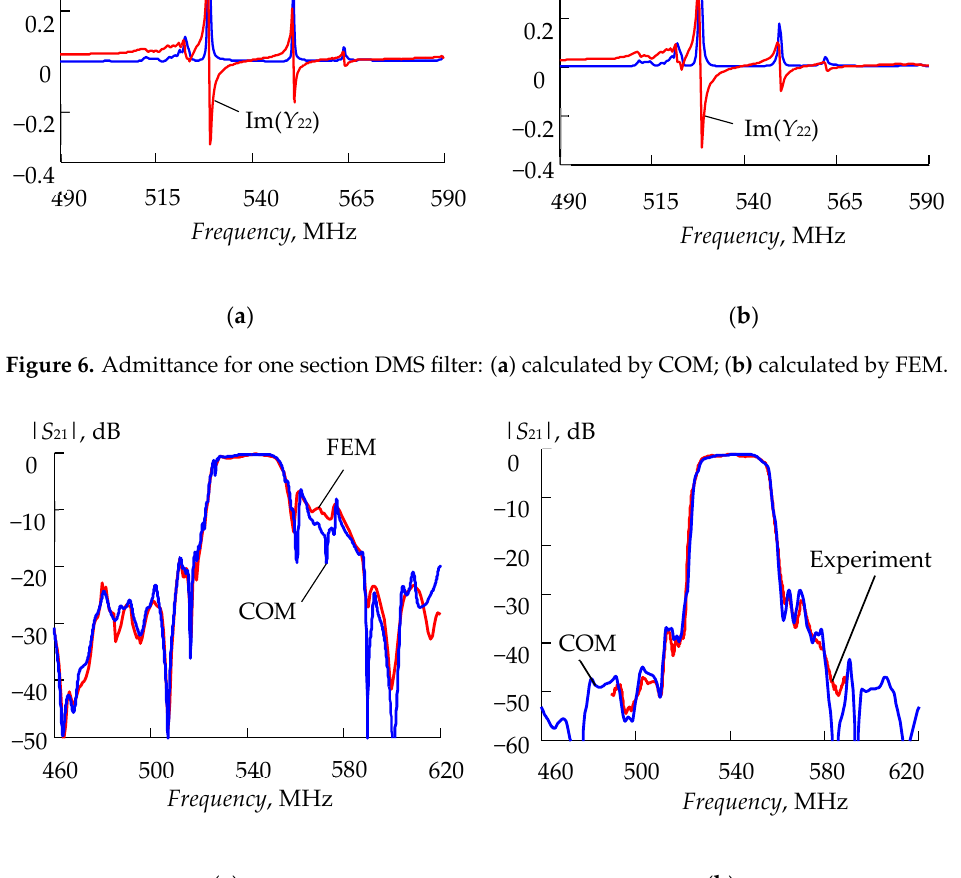
Table 1. Comparison of the result of calculating one section DMS filter based on two approaches: FEM in COMSOL and COM based P-matrices.